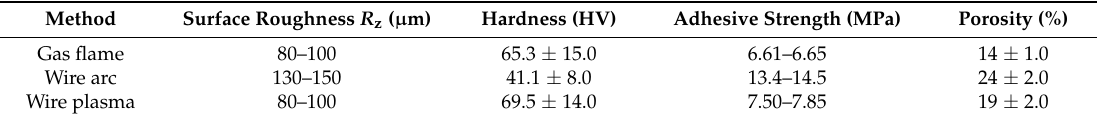
Table 4. Results of the measured roughnesses, hardnesses, adhesive strengths, and porosities obtained for coating layers deposited using the three thermal spray guns. In this table, “–” indicates the upper and lower values of two measurements, and “±” indicates the ranges of more than three measurements with their average values at each front.